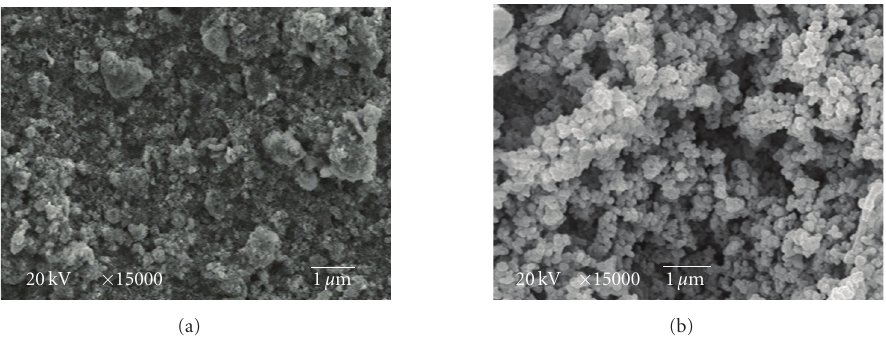
Figure 2: SEM images of LiFePO 4 : (a) without carbon; (b) with carbon